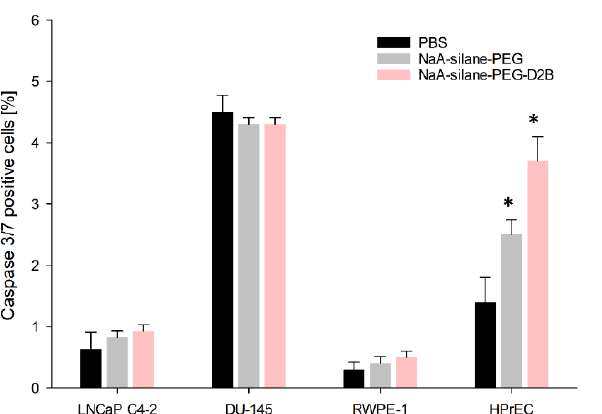
Figure 3. The effect of NaA-silane-PEG and NaA-silane-PEG-D2B on the proportion of caspase 3/7 positive cells. LNCaP C4-2 cells, DU-145 cells, RWPE-1 cells and HPrEC cells were exposed to 50 mcg mL − 1 of NaA-silane-PEG or NaA-silane-PEG-D2B for 96 h. Data are expressed as the mean ± standard deviation (SD) from three independent experiments. * p < 0.05 versus control group.